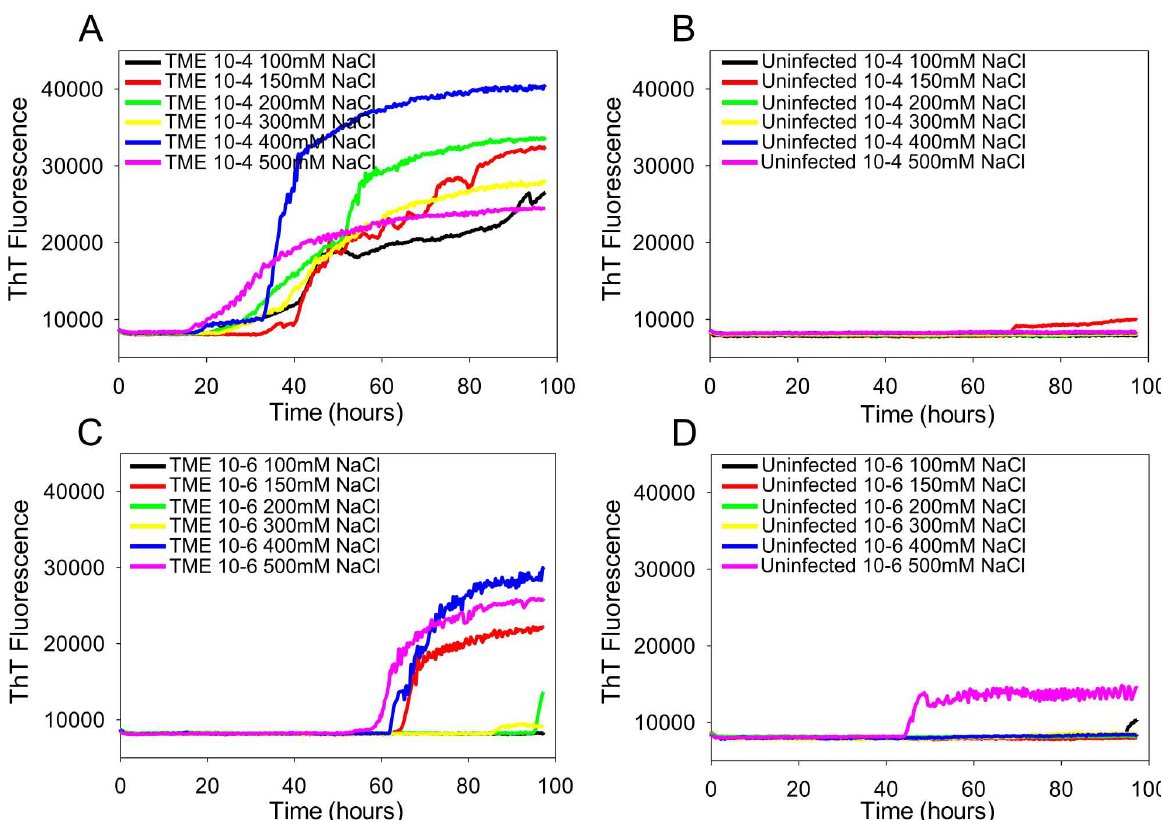
Fig 2. RT-QuIC sodium chloride titration for TME-infected and uninfected cattle brain samples. RT-QuIC reactionswere seeded with 10 − 4 (A, B) and 10 − 6 dilution(C, D) of TME-infected and uninfectedcattle brain homogenates using a range of NaCl concentrations (100–500mM) with the full-lengthbPrP wild type (aa 25–241)as substrate. Data are presented as mean ThT fluorescence of 8 reactions conducted as 2 repeatsof 4 reactions.The positivethresholdwas calculateas ~10,000relative fluorescence units of normal cattle brain homogenates.